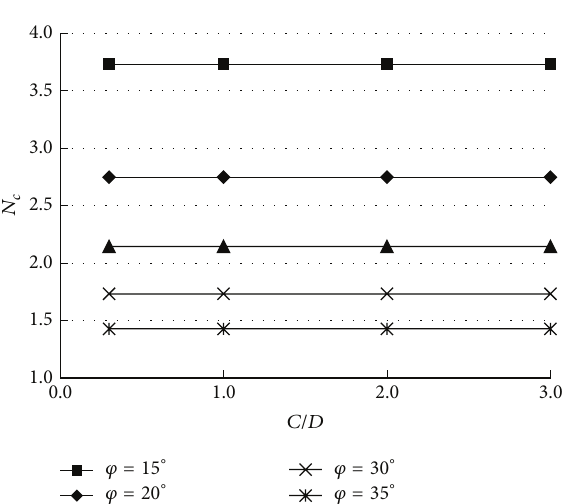
Figure 3: The values of 𝑁 𝛾 .